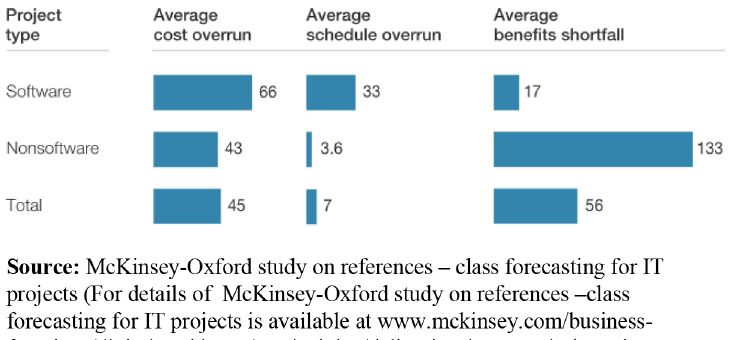
Figure 3. Percentage of